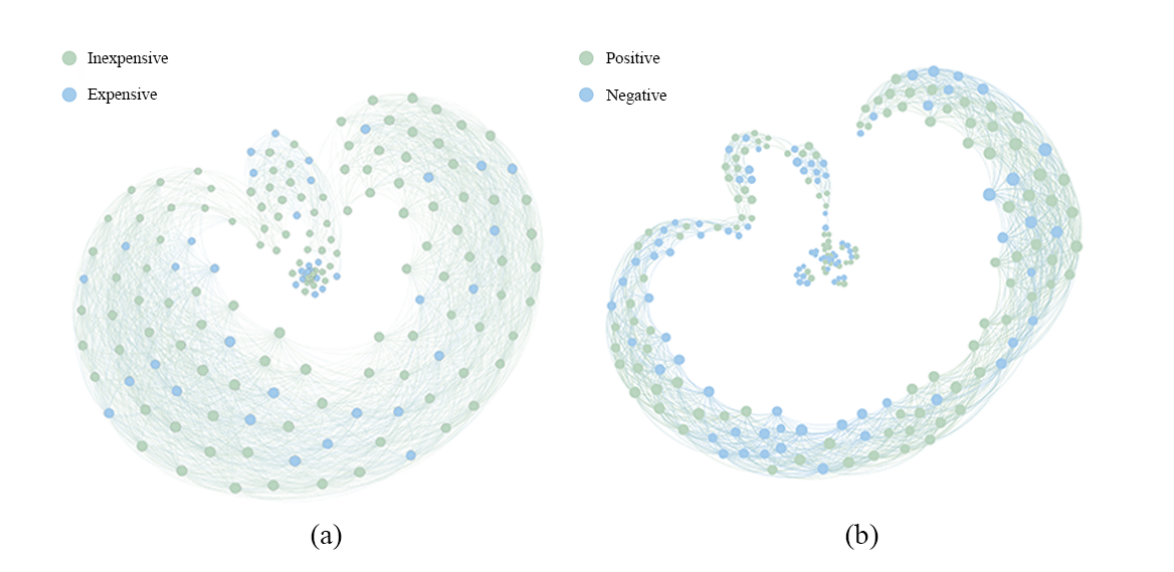
Figure 3. Weibo's attitude contagion map: (A) price and (B) side effects. Points represent Weibo messages that appear in the figure in clockwise order, ending with the point at the center of the